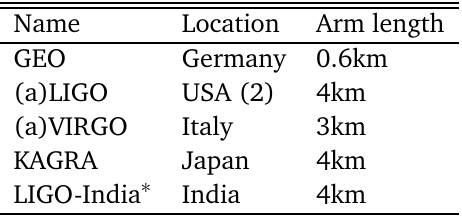
Table 3: Current and planned (*) ground-based gravitational wave detectors using laser interferometry.